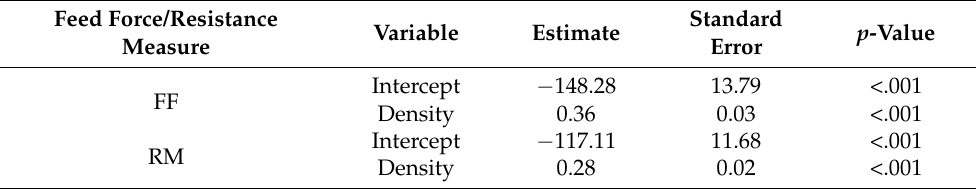
Table 12. Estimates for regression models of FF and RM with density as the